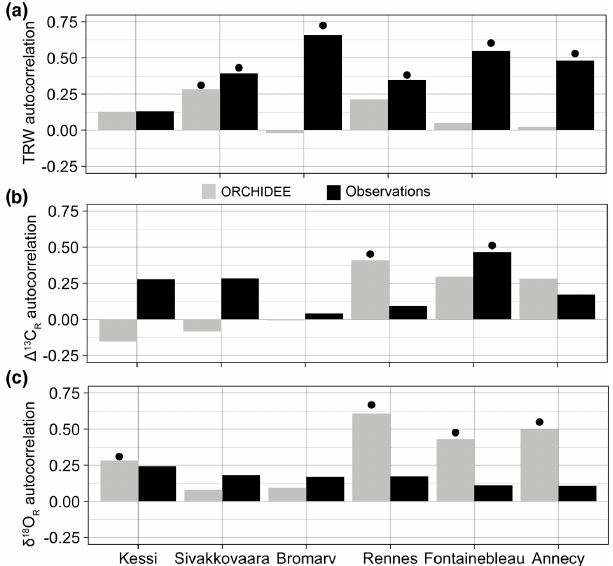
Figure 5. First-order autocorrelation in observed (black) and simu- lated (gray) tree-ring variables over the period 1960–2000. (a) Tree- ring width. (b) (cid:49) 13 C R . (c) δ 18 O R . For Annecy the period of analy- sis is 1971–2000. Significance at the 95% confidence level is indi- cated by the black